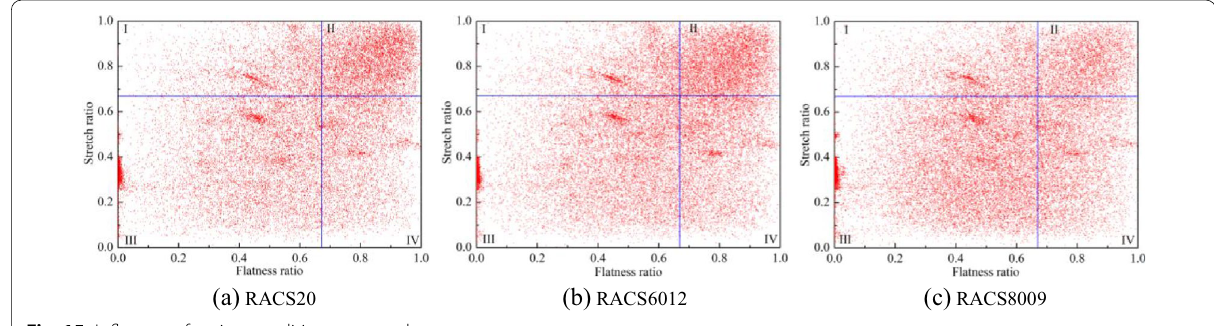
Fig. 15 Influence of curing condition on pore shape